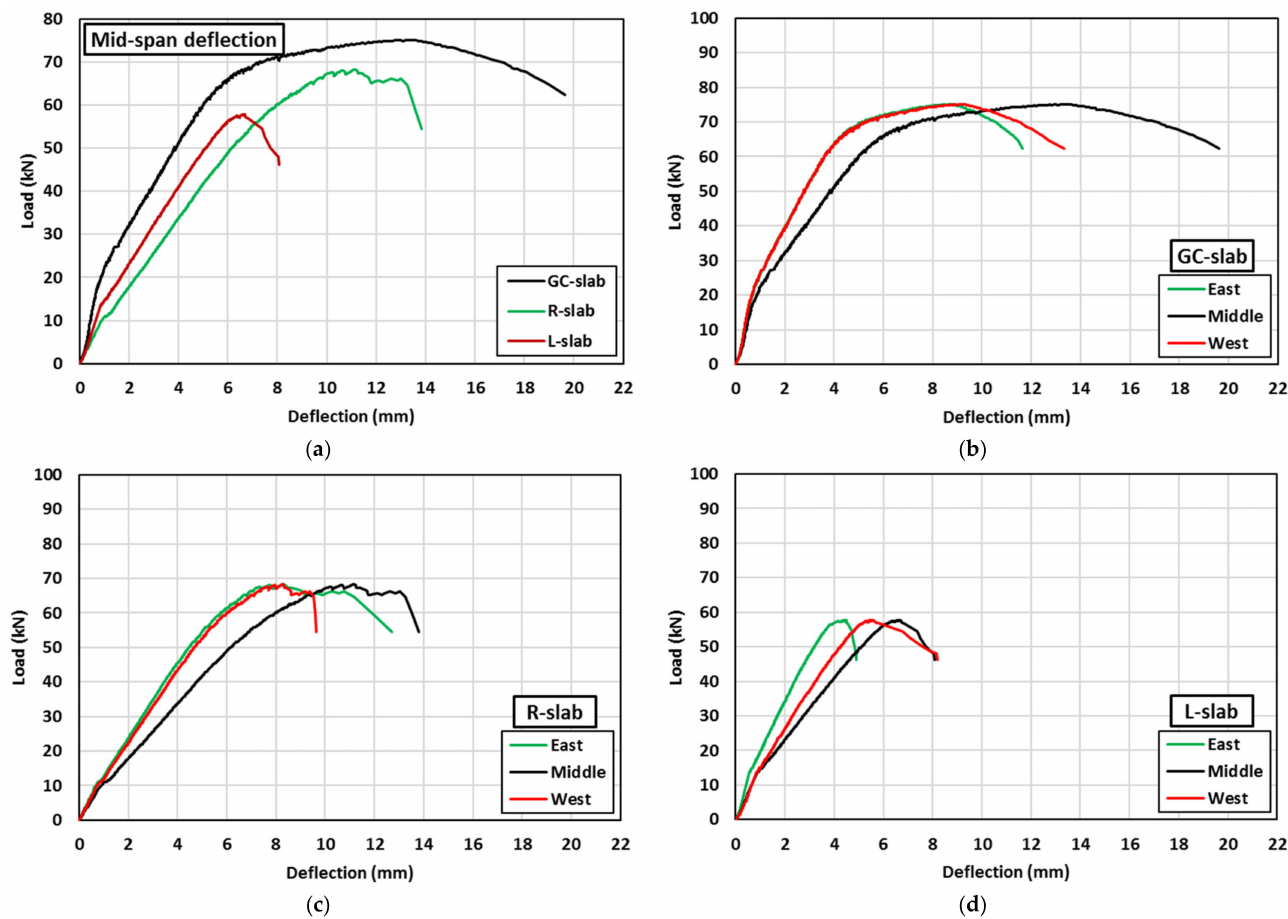
Figure 14. Load-deflection behaviour at several locations for the tested slabs: ( a ) comparison of all slabs, ( b ) GC-slab, ( c ) R-slab, and ( d )